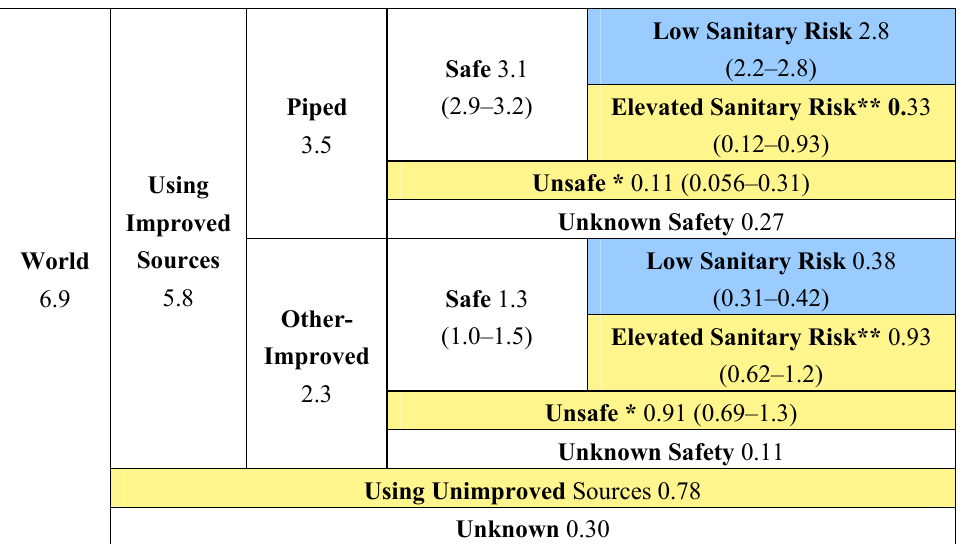
Figure 1. World population by water contamination status and sanitary risk for 2010